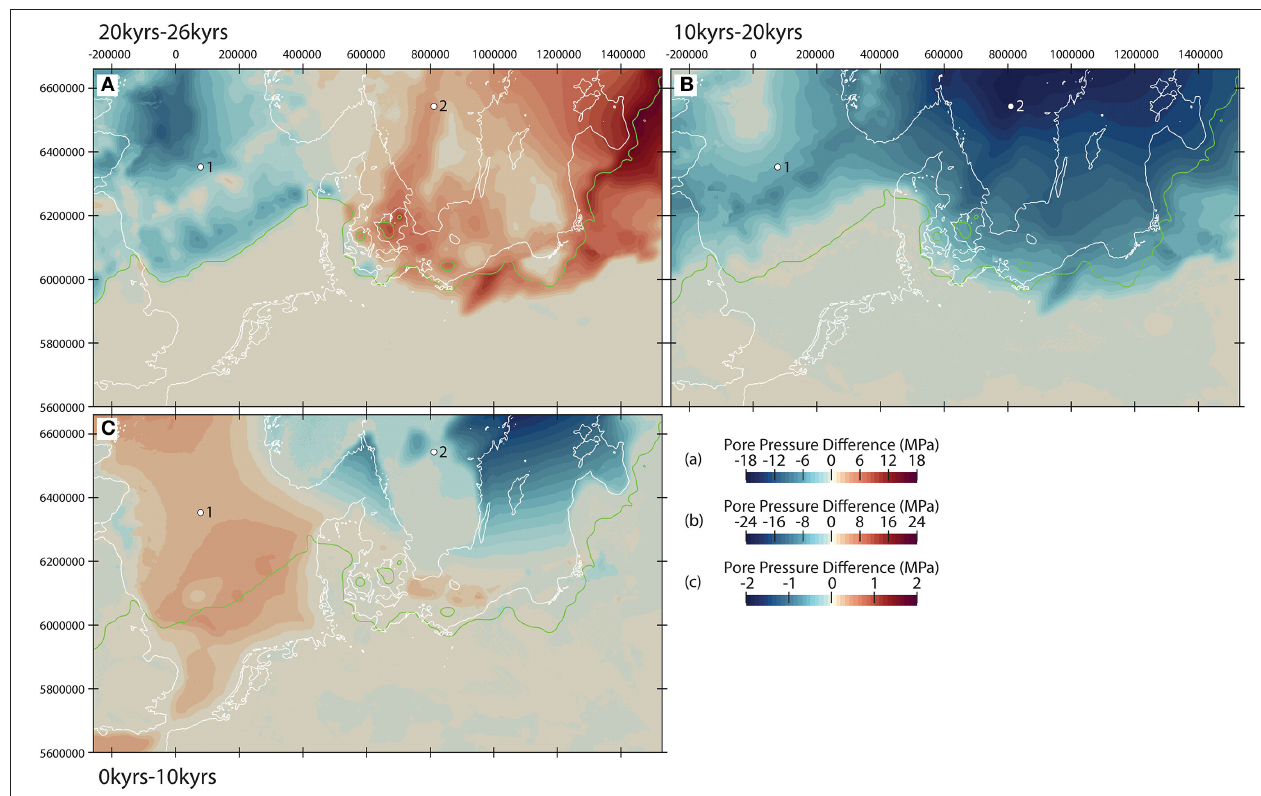
FIGURE 4 | Pore pressure difference between selected time steps at − 1,000m b.s.: (A) pore pressure at − 20 kyrs minus pore pressure at − 26 kyrs, (B) pore pressure at − 10 kyrs minus pore pressure at − 20 kyrs, (C) Pore pressure at 0 kyrs (present) minus pore pressure at 10 kyrs, and (A–C) white lines = coastline, green line = maximum ice extent at − 22 kyrs, white dots represent extraction locations from Figure 7 : 1 = central North Sea, 2 = northern crust. Coordinates are in UTM Zone